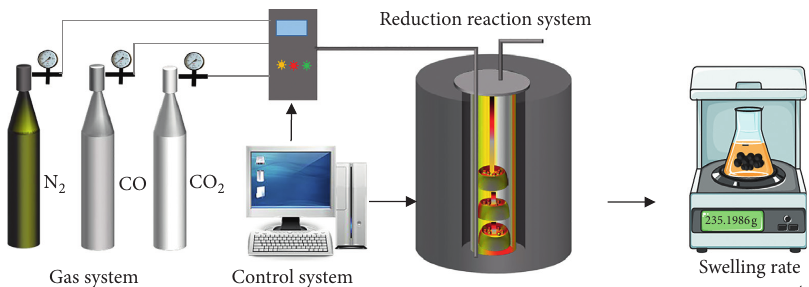
Figure 3: Flowchart of pellets reduction swelling experiment.